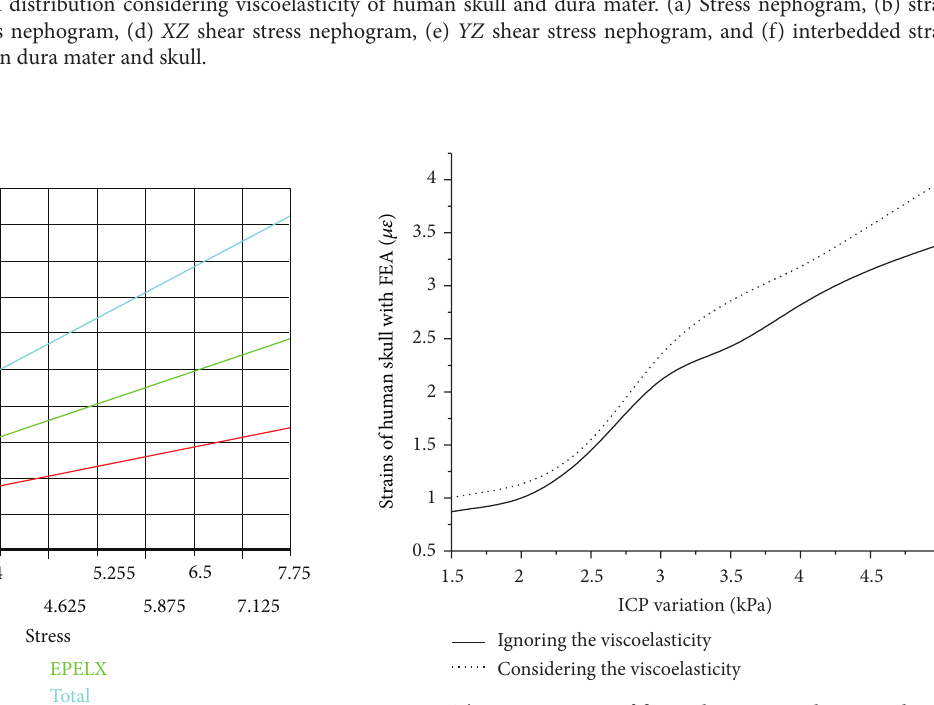
Figure 8: The strain curves of finite element simulation under the conditions of ignoring and considering the viscoelasticity of human skull and dura mater with the changing ICP from 1.5kPa to